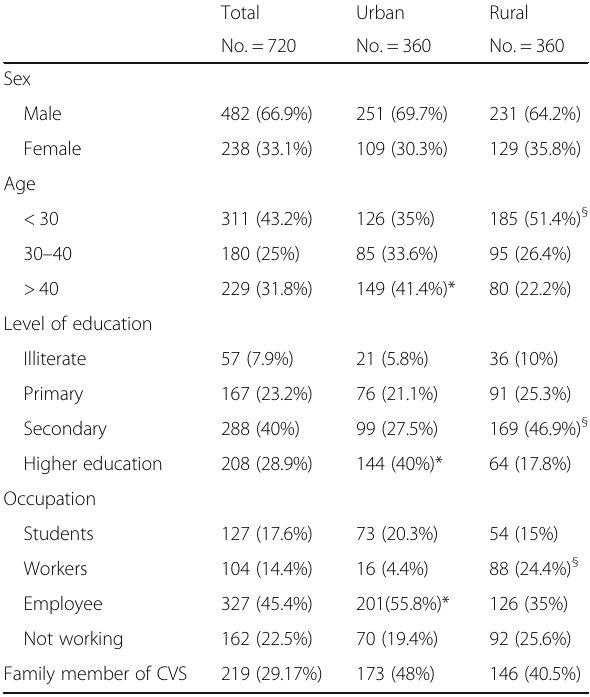
Table 1 Demographic data of the urban and rural participants